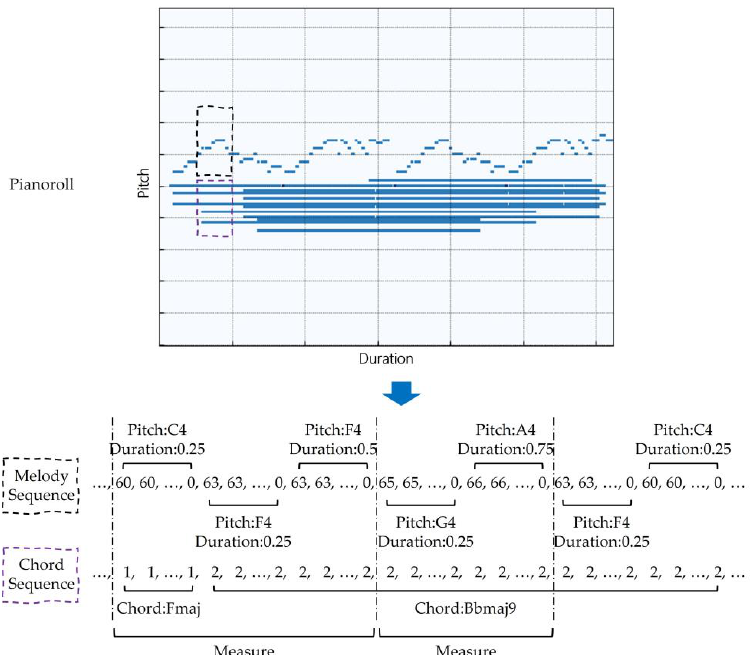
Figure 1. Example of melody and chord sequences converted from a piano roll. In the piano roll, a portion of the corresponding melody and chord were truncated. The black dotted box represents the truncated melody section, while the purple represents the truncated chord. The truncated melody and chord are converted to melody and chord sequences, with each segment between two dotted lines representing the length of one measure.